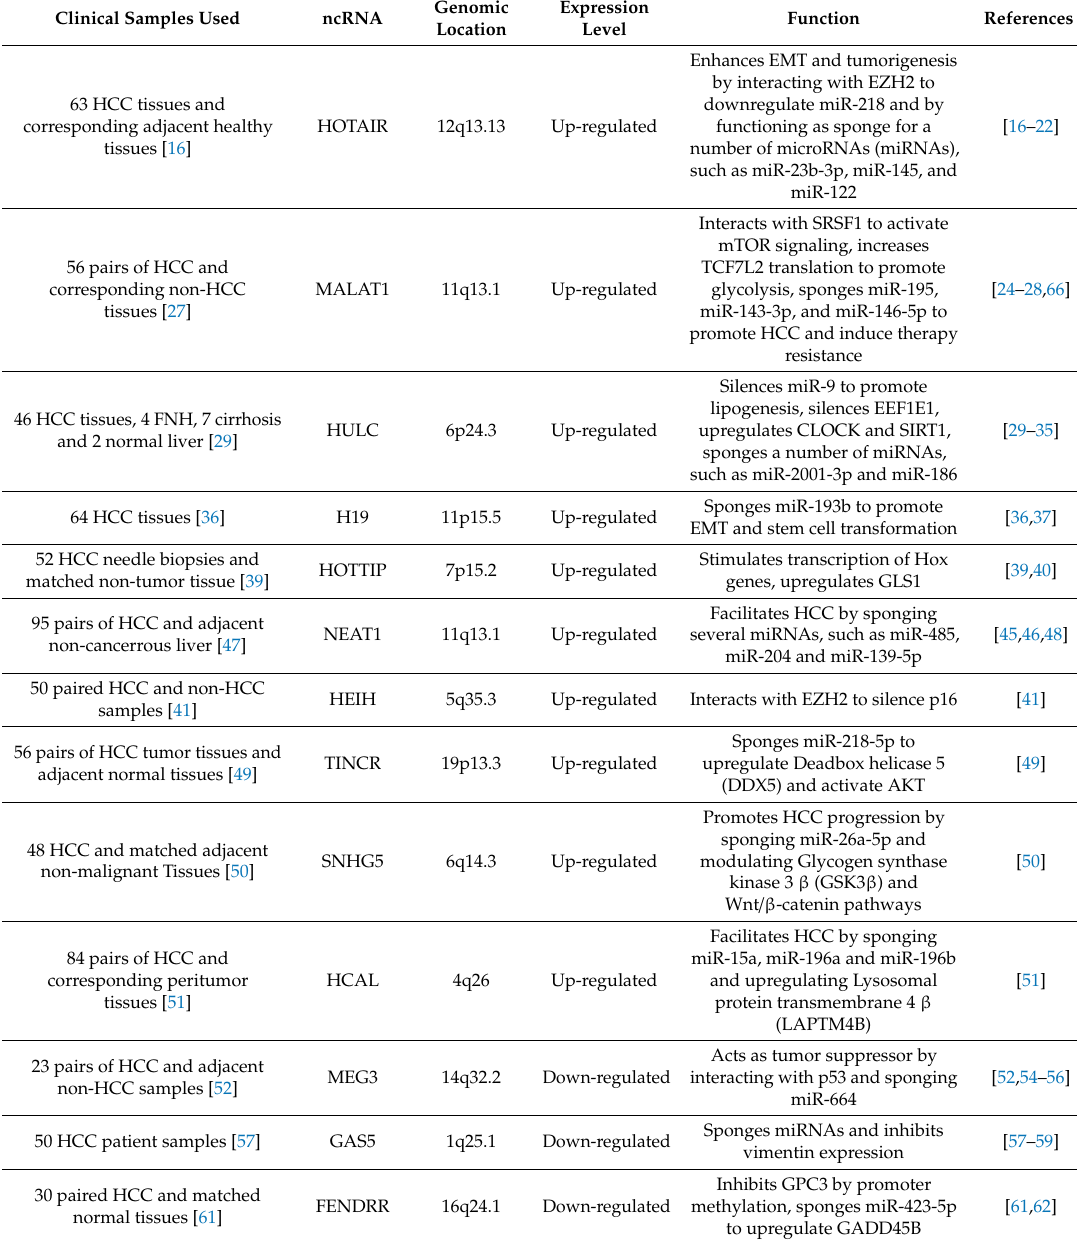
Table 1. Examples of dysregulated long non-coding RNAs (lncRNAs) in hepatocellular carcinoma